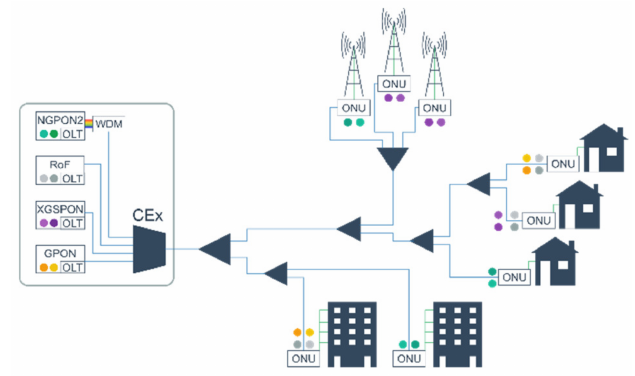
Figure 1. Standard PON